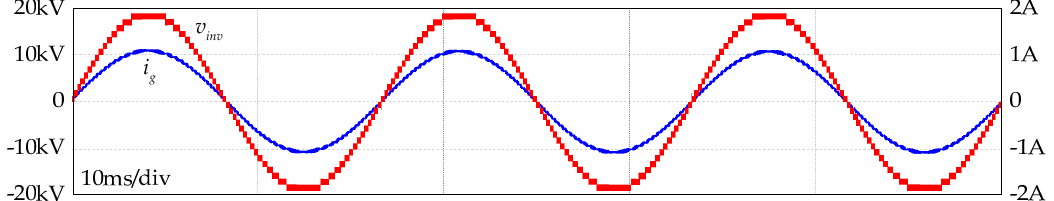
Figure 16. Simulated v inv and i g with 10 modules.